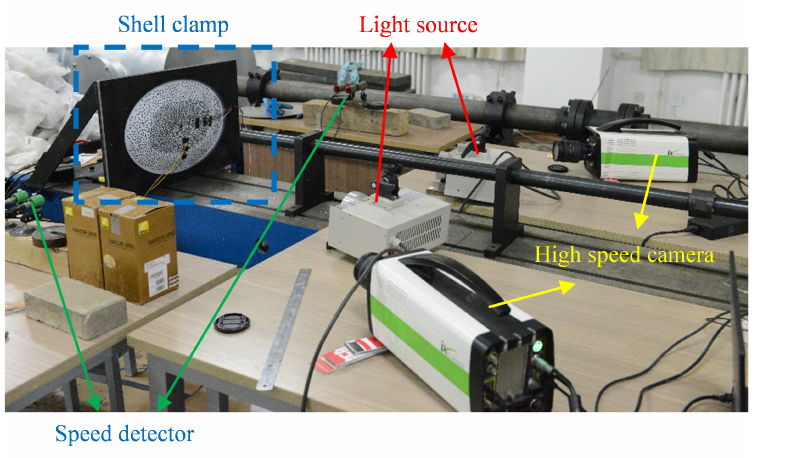
Figure 1. Experimental setup.